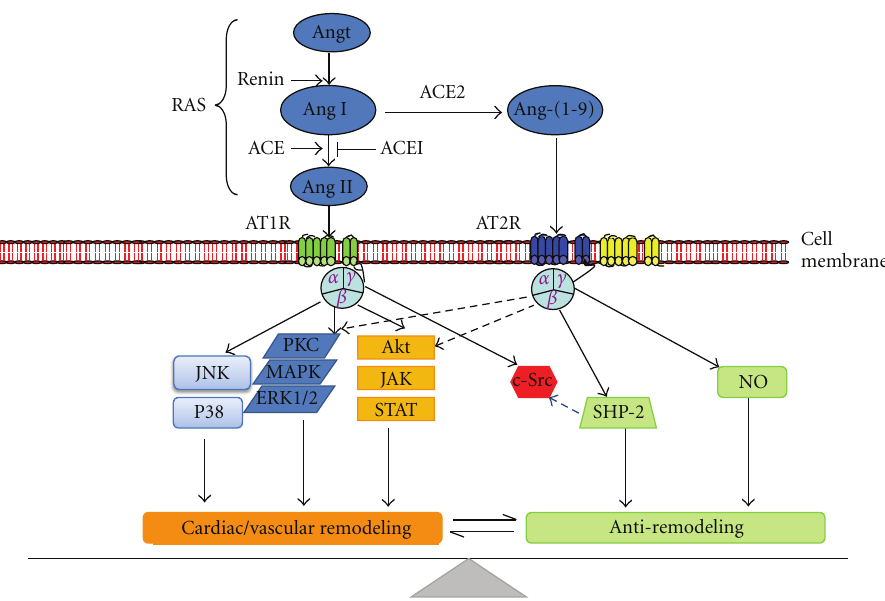
Figure 3: Signaling events and cellular e ff ects induced by Ang II via AT1R and opposing e ff ects of Ang-(1–9) acting through AT2R. Proposed Ang-(1–9)-dependent mechanisms that antagonize the cardiovascular remodeling e ff ects of Ang II. ACE2 can directly cleave Ang I to form Ang-(1–9). This peptide activates the AT2R to initiate signaling pathways that antagonize AT1R-mediated tyrosine kinase cascades. In this simplified scenario, Ang-(1–9) increases SHP-1 tyrosine phosphatase activity to inactivate src-dependent signaling. AT2R activation also acts other pathways such as NO-AKT. AT1R: Ang II type 1 receptor; AT2R: Ang II type 2 receptor; ERK1/2: extracellular signal-regulated kinase 1/2; JAK: Janus-activated kinase; MAPK: mitogen-activated protein kinase; p38: p38 MAPK; PKC: protein kinase C; STAT: signal transducer and activator of transcription; NO: nitric oxide; SHP-1: protein tyrosine phosphatase SH2 domain-containing phosphatase 1; MEK: mitogen/ERK kinase. Solid arrows indicates activation broken arrows indicates